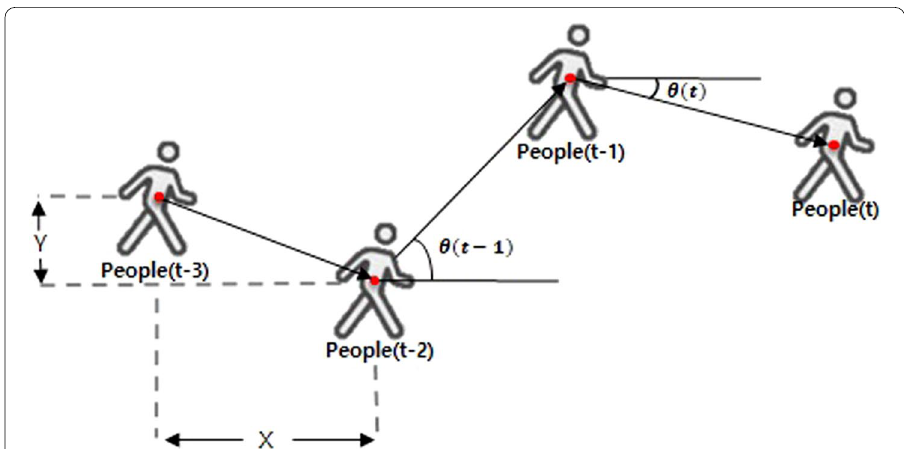
Fig. 4 Object angle difference measurement